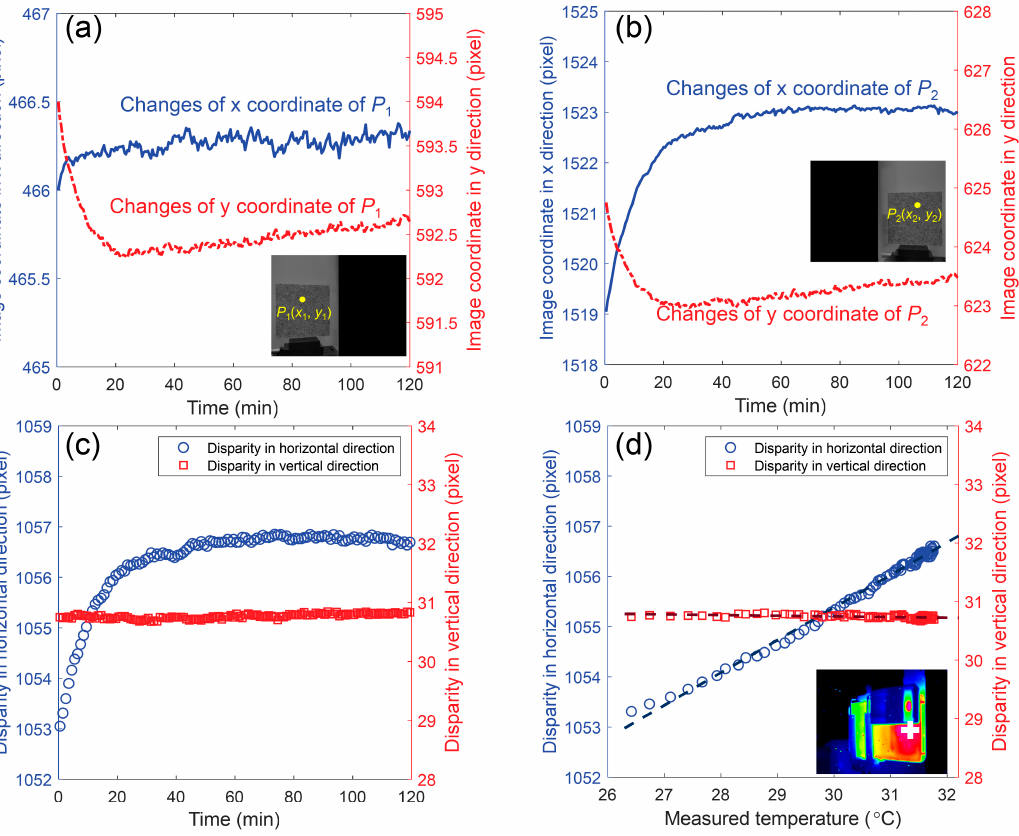
Figure 9. The variations of the image coordinates of the two projection points ( a ) P 1 and ( b ) P 2 as a function of the test time, and the disparities of point P (i.e., the differences in image coordinates between P 1 and P 2 ) as a function of ( c ) the test time and ( d ) the measured temperature.